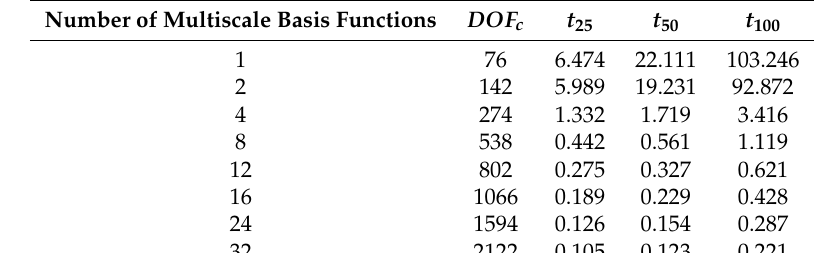
Table 2. Numerical results for Test 1.NBC . Relative L 2 error (%) for different numbers of multiscale basis functions.